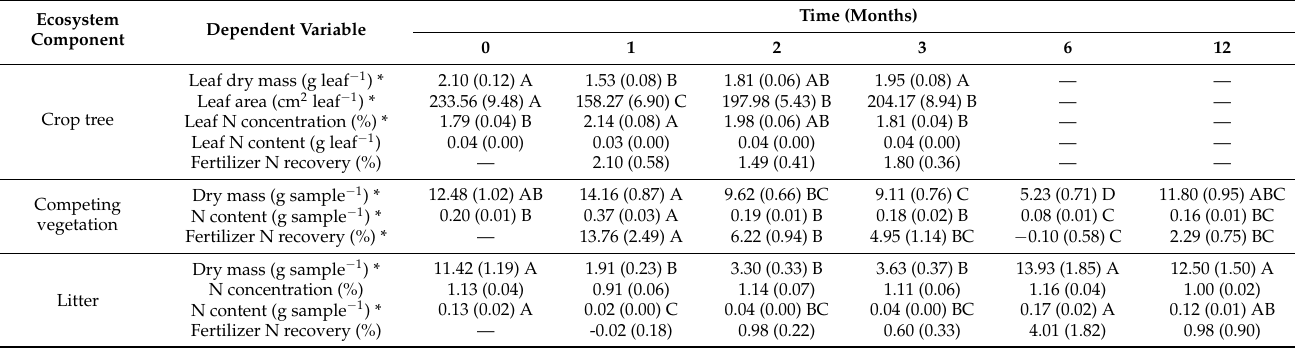
Table 3. Mean values ( ± standard error of the mean) for plant-related response variables for which no interaction was observed, by time. For crop tree variables, values displayed are means by sampling time (i.e., averaged across treatments for a given time; n = 8). For competing vegetation and litter variables, values displayed are means by sampling time ( n = 8), with each sample being represented by four 0.0625 m 2 sub-sampling areas surrounding each crop tree from which all vegetation and litter was collected. Fertilizer N recovery values are the percentage of fertilizer-derived 15 N recovered from the specified component at each sampling time relative to the amount initially applied.